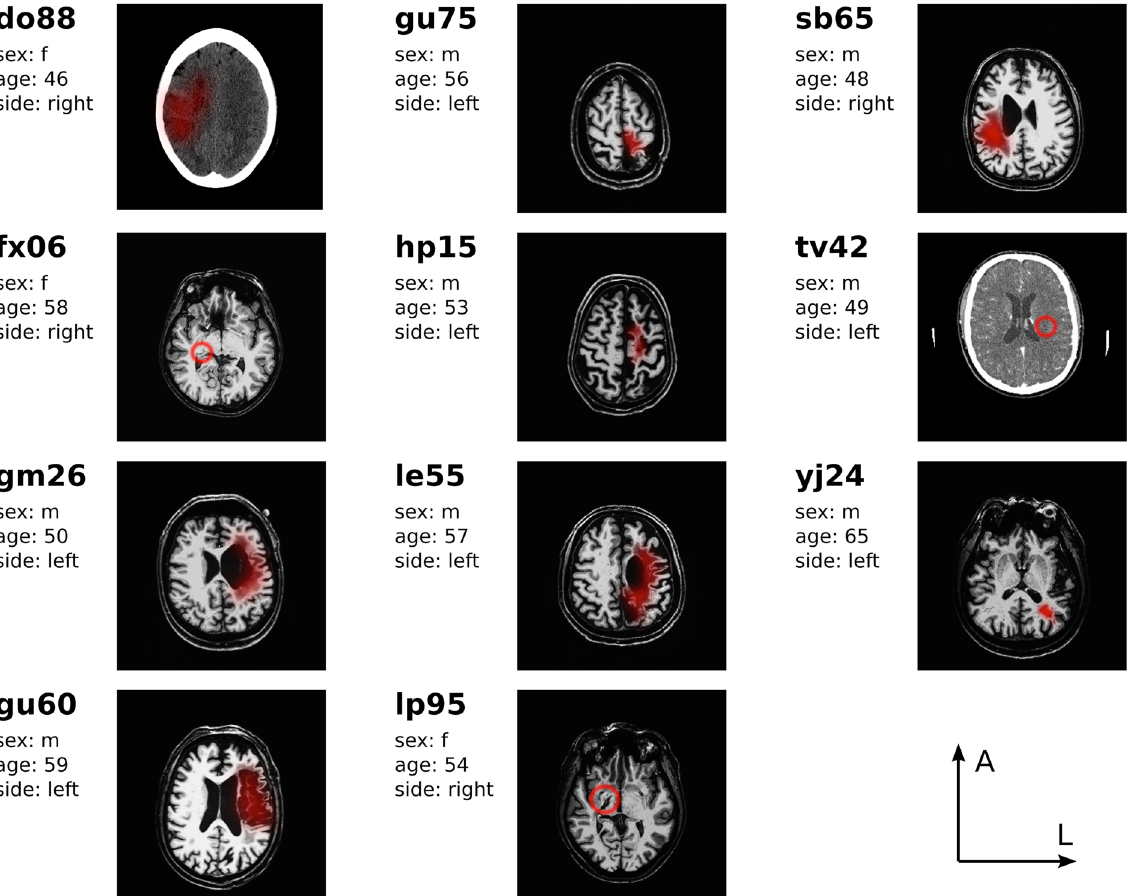
Figure 1. Description of eleven included patients. (do88) right hemispheric medial cerebral artery infarct including medial parts of S1 and M1 extending into the parietal lobe (fx06) right subcortical lesion touching the posterior limb of the internal capsule (gm26) posthemorrhagic lesion on the left including cortical and subcortical S1 and M1 (gu60) left-sided lesion in A.-lenticulostriata territory touching cortical and subcortical parts of prefrontal and medial S1 and M1 extending into parietal lobe (gu75) lesion following intracerebral bleeding on the left touches medial S1 and M1 extending into superior parietal cortex (hp15) infarct of the left medial cerebral artery touching the medial S1 and M1 (le55) left-sided hemorrhage touching cortical and subcortical parts of frontal, medial S1 and M1 including superior parietal cortex (lp95) ischemia of the A.- thalamostriata territory including the posterior limb of the right internal capsule (sb65) right posthemorrhagic lesion including medial S1 and M1, posterior limb of the internal capsule extending into the temporal lobe (tv42) left-sided infarct including the posterior external capsule (yj24) ischemia including the left posterior limb of the internal